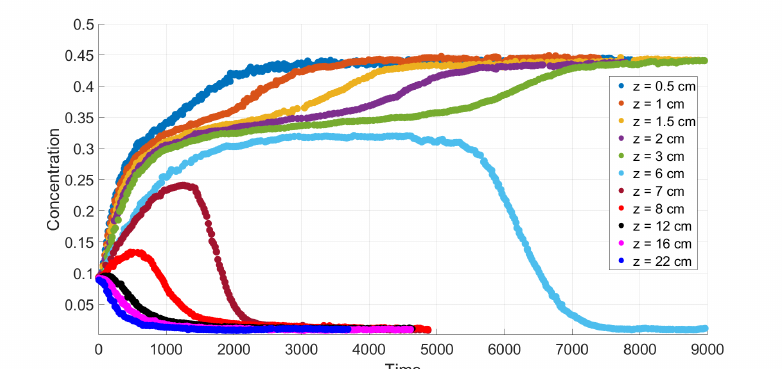
Figure 6. Experimental values of average concentration versus time at different height levels in a polymer solution [4].